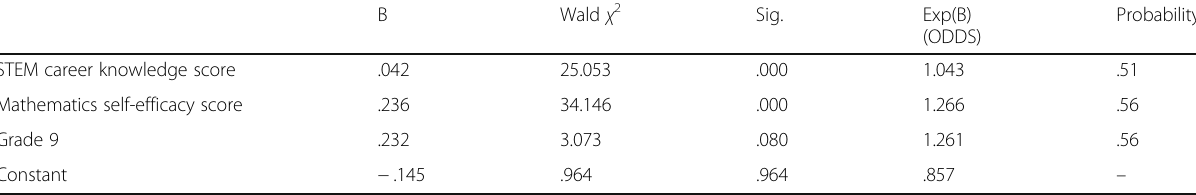
Table 10 Bivariate logistic regression of the correlations between grade level, STEM knowledge score and mathematics self-efficacy by students ’ likelihood to pursue a STEM career